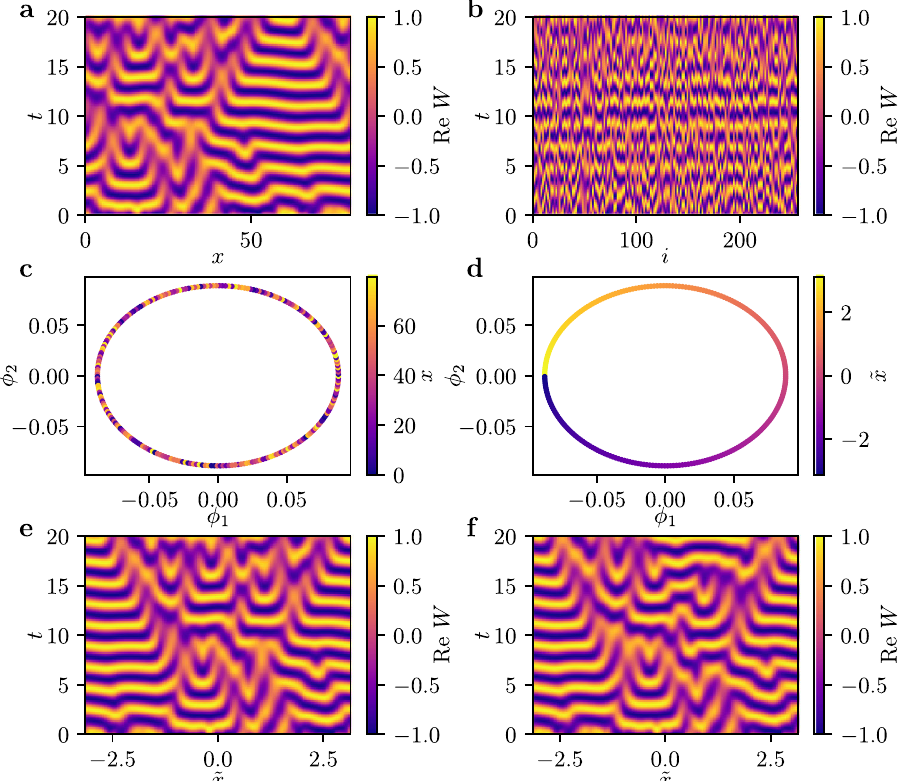
Fig. 2 Data-driven PDE for the chaotic dynamics in the complex Ginzburg-Landau equation. a The real part of the complex fi eld W ( x , t ) obtained from simulating Eq. (2) with N = 256 mesh points after initial transients have decayed. b Removing the spatial label yields a collection of N time series plotted here in random sequence. c Using manifold learning (here diffusion maps), one fi nds that there exists two modes ϕ 1 and ϕ 2 parametrizing these time series. Each point corresponds to one of the N time series, and is colored by its scrambled spatial location x . d Having obtained the embedding, we can introduce an emergent coordinate ~ x parametrizing the circle spanned by ϕ 1 and ϕ 2 . e The real parts of the time series parametrized by ~ x . f Real part of simulation predictions for the complex variable W starting from an initial condition in our test set, using the partial differential equation model learned with ~ x as the spatial variable and a periodic